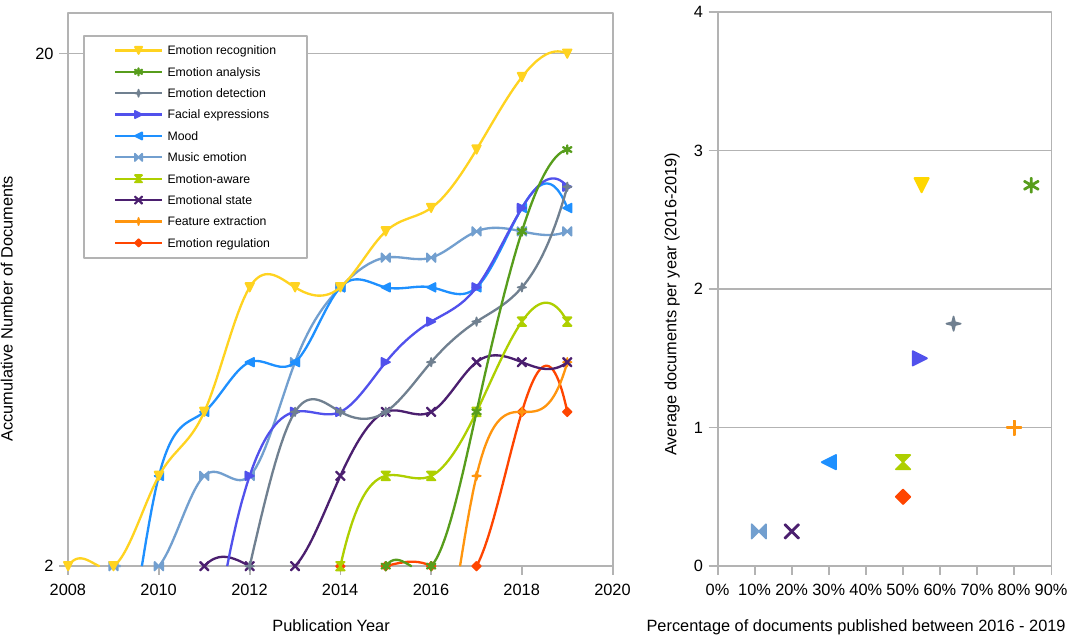
Figure 6. Evolution and relevance of emotions in a ff ective